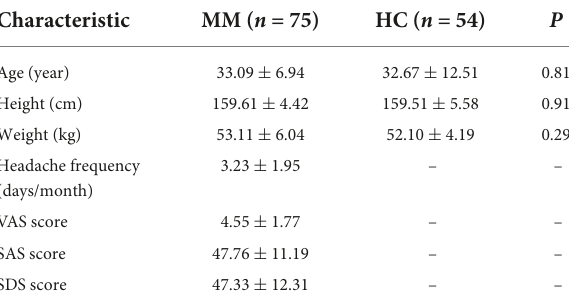
TABLE 1 Demographic and clinical characteristics of